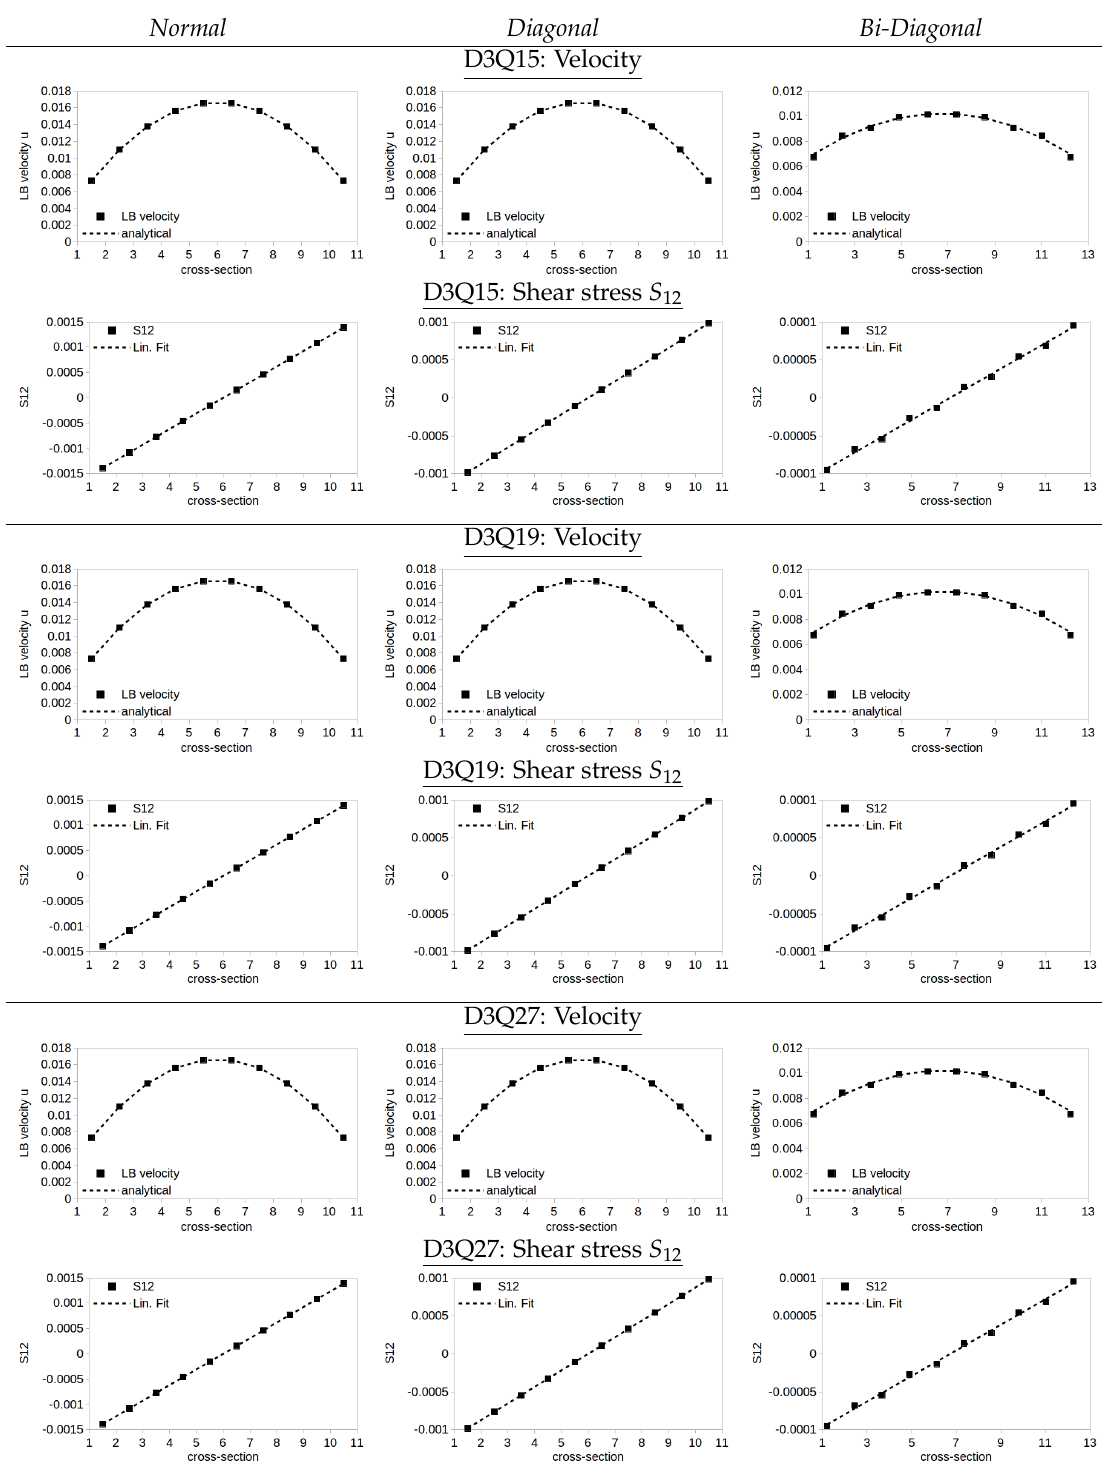
Figure 4. Velocity and stress profiles in setups Normal , Diagonal , Bi-Diagonal for discretizations D3Q15, D3Q19, D3Q27. The best approximation “Lin. Fit” matches the analytic solution within a tolerance of ≤ 1%. The small oscillations in the setup Bi-Diagonal stem from the evaluation and data extraction of flow quantities from the Cartesian grid data structure, abstaining from interpolation despite the consideration of a rotated